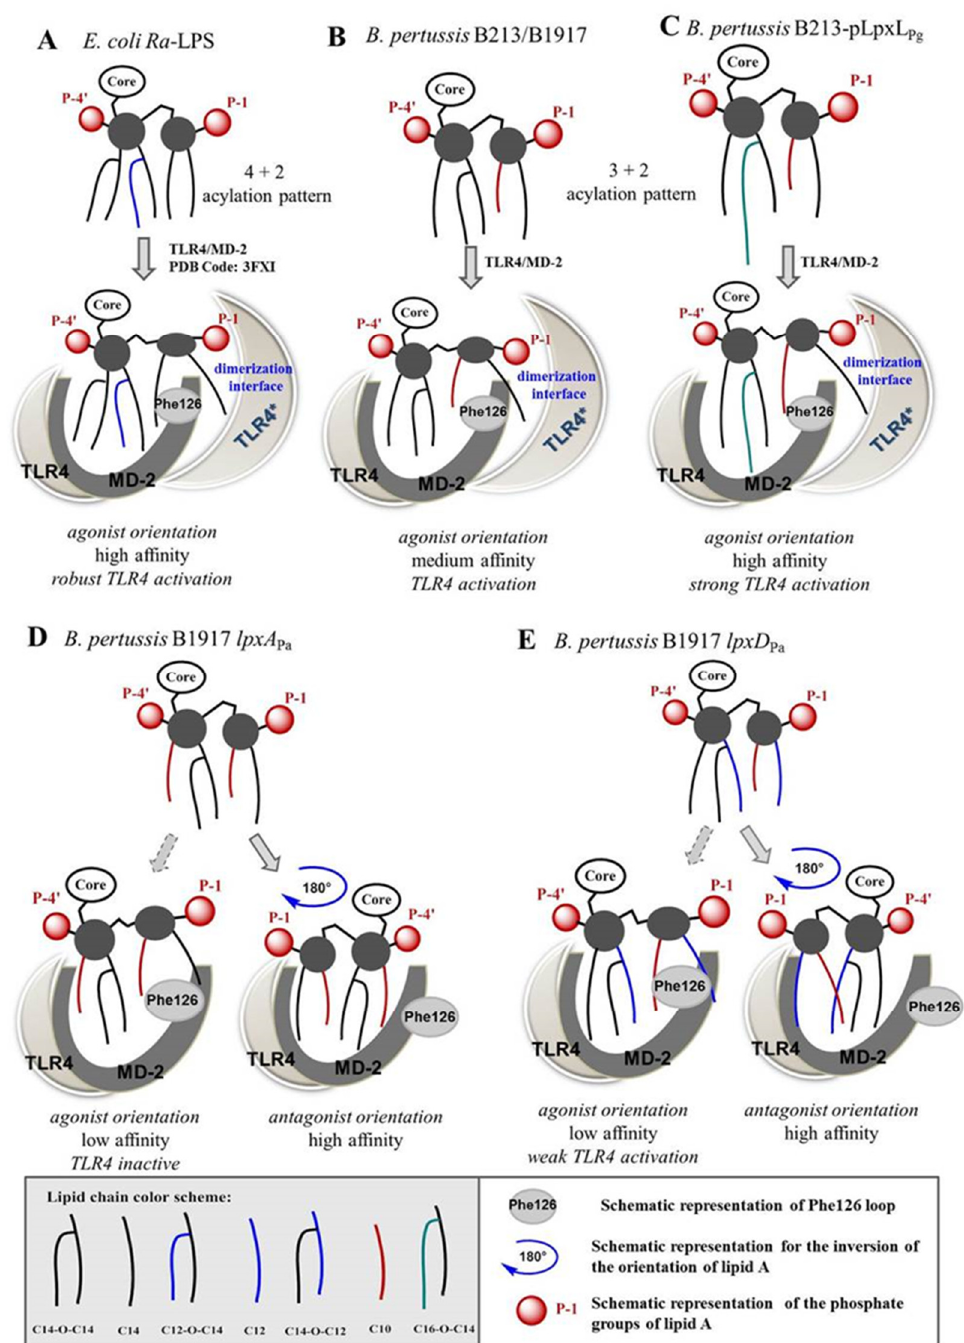
Figure 5. The proposed mode of interaction of LPS with hTLR4/MD-2. The proposed binding modes of LPS of E. coli K-12 (PDB code: 3FXI) ( A ), B. pertussis B213/B1917 ( B ), and several mutant LPS derivatives generated in this study ( C – E ) are shown. The binding poses (orientation and affinity) with MD-2 are displayed below the figures.